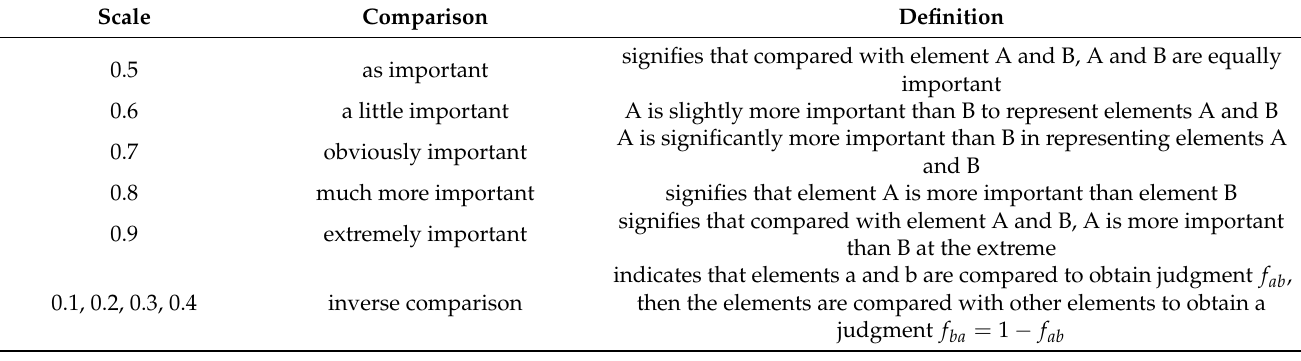
Table 1. Quantitative scale